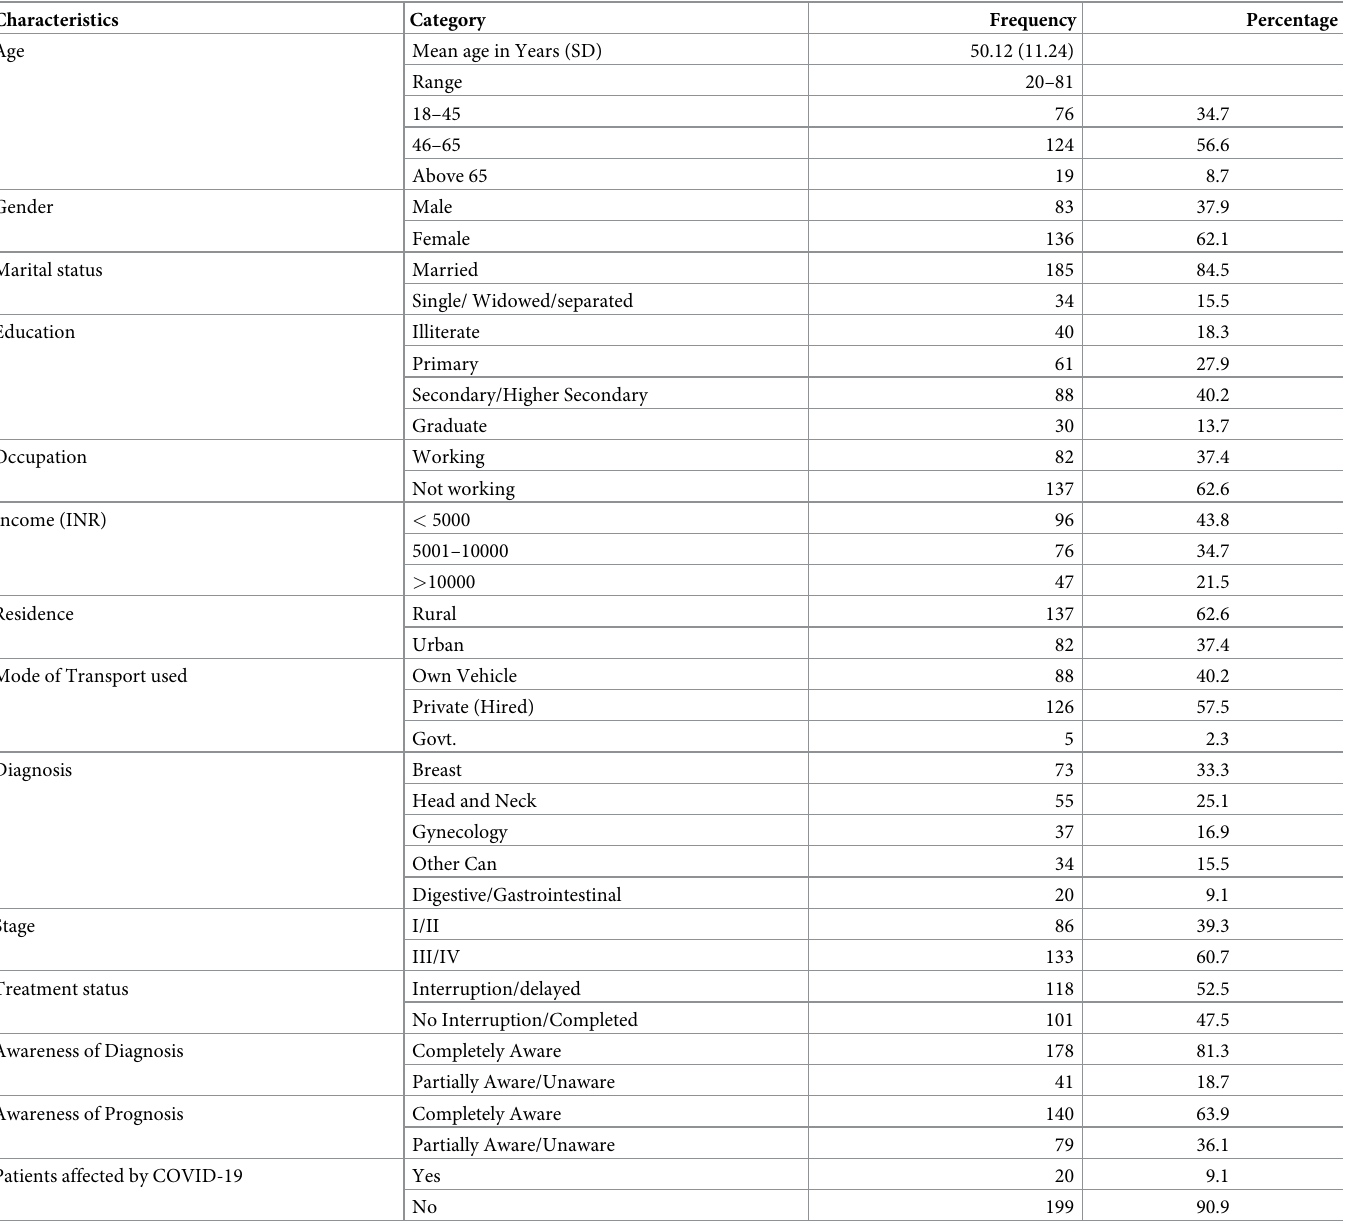
Table 1. Personal and clinical characteristics of study participants (n =